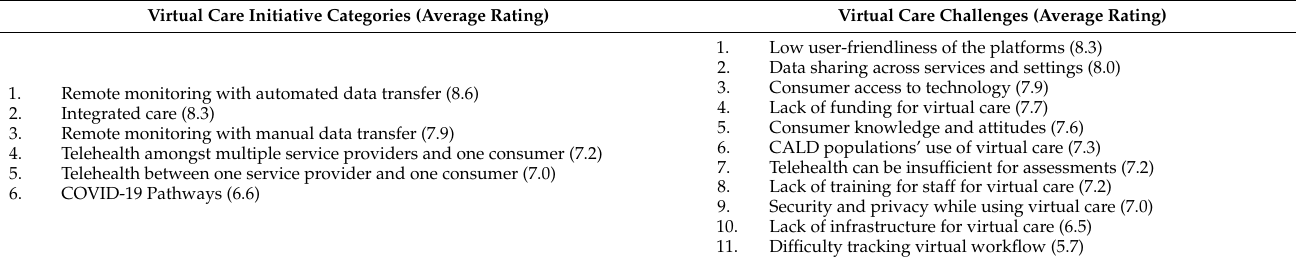
Table 3. Perceived importance for further information gathering for virtual care initiative categories and challenges, listed in order of highest to lowest